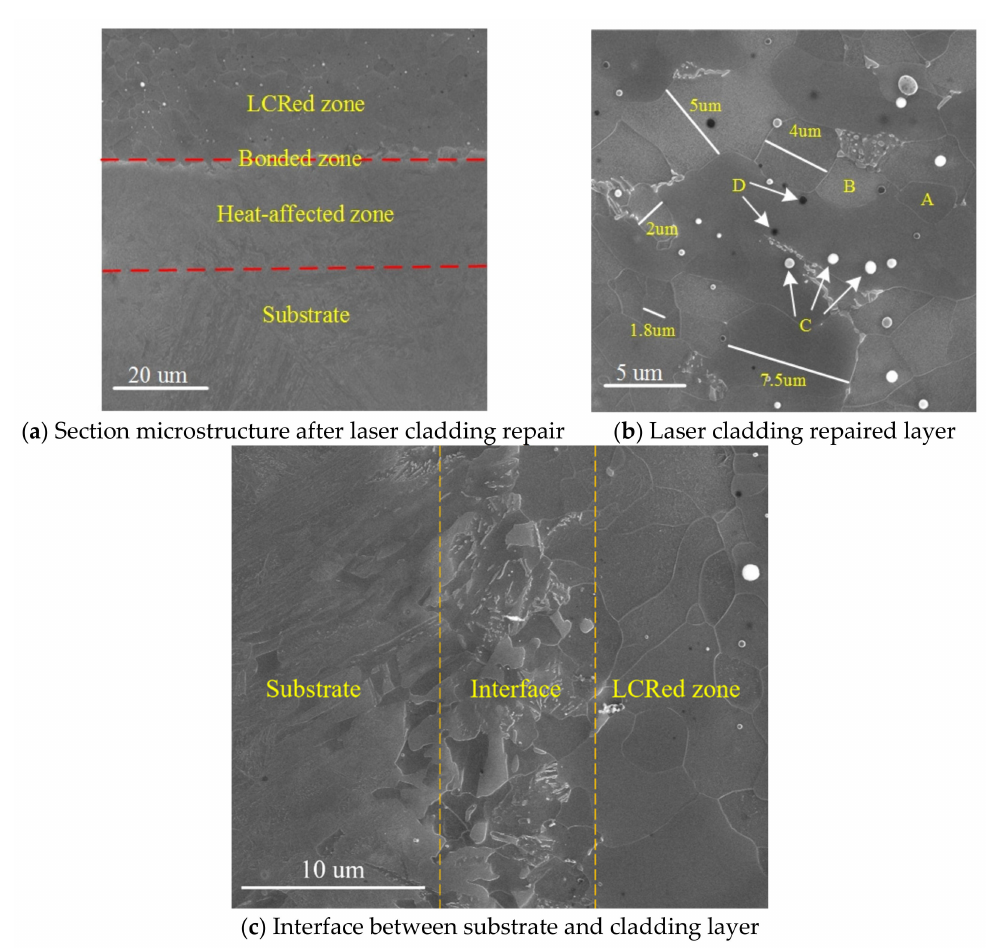
Figure 5. SEM morphology for specimen